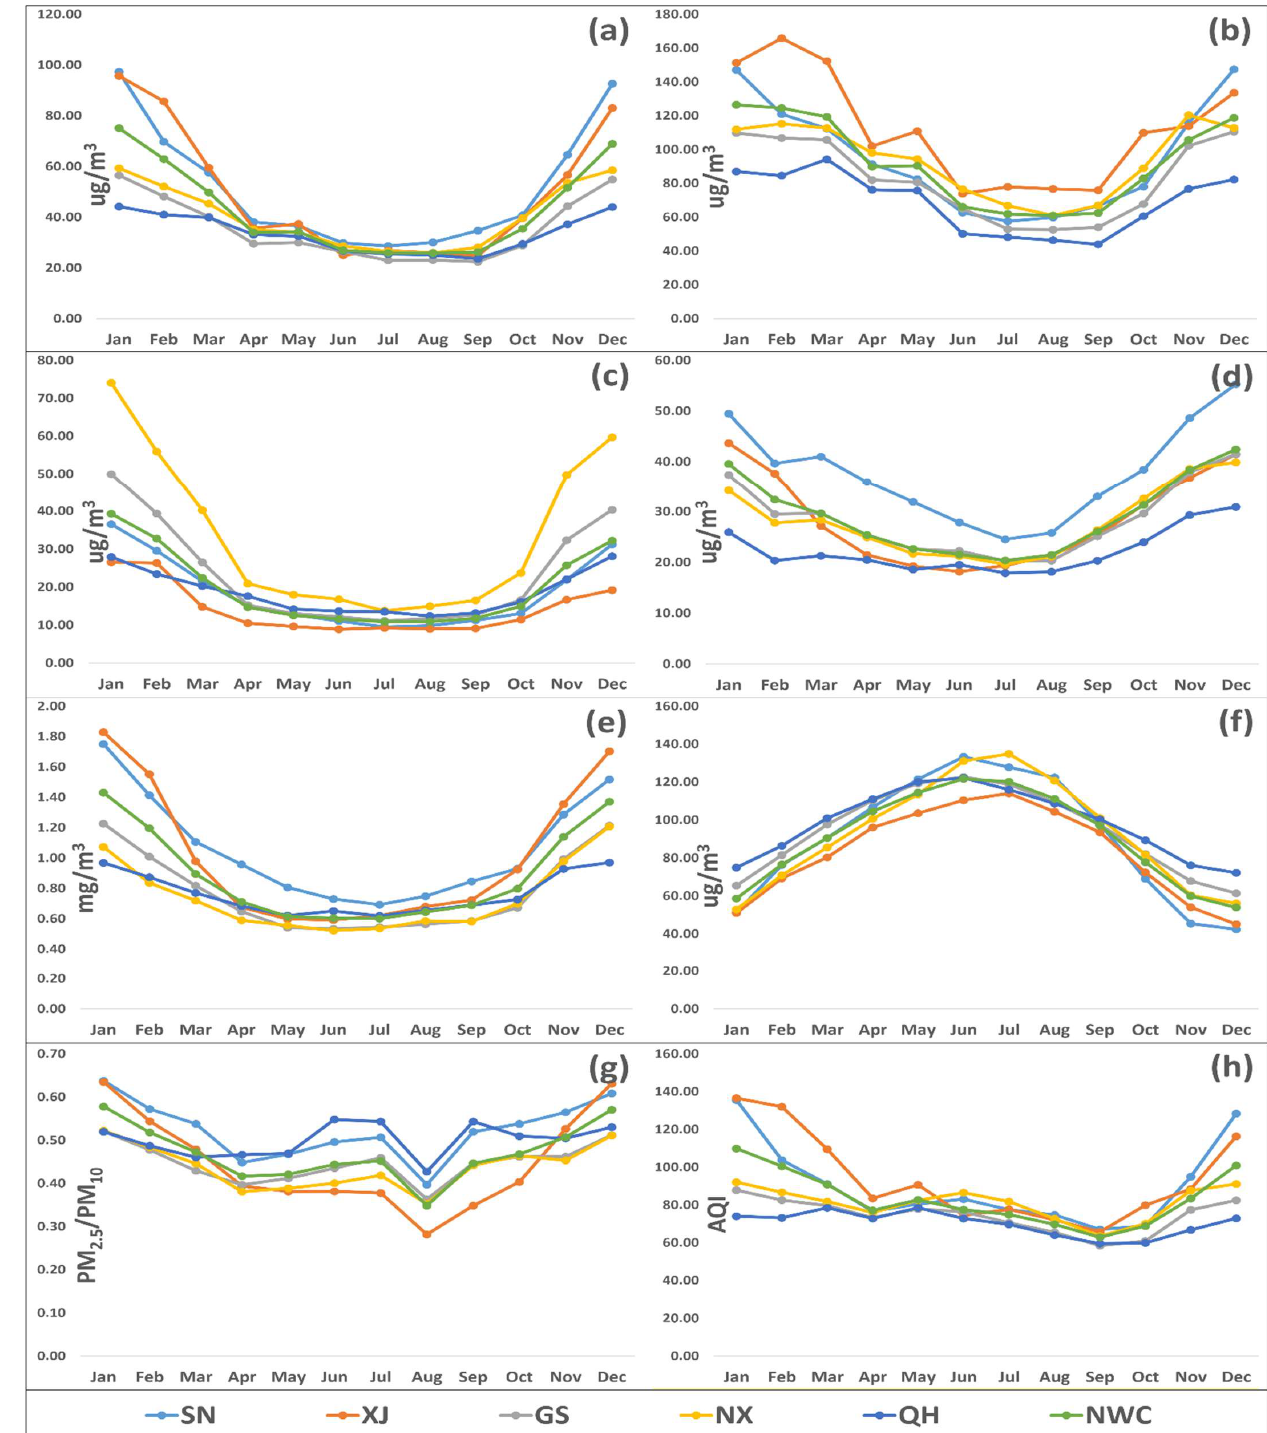
Figure 4. The monthly average concentration of PM 2.5 ( a ), PM 10 ( b ), SO 2 ( c ), NO 2 ( d ), CO ( e ), O 3 ( f ), PM 2.5 /PM 10 ( g ), and AQI ( h ) in five provinces (Shaanxi (SN), Xinjiang (XJ), Gansu (GS), Ningxia (NX), and Qinghai (QH)) of northwest China (NWC) between 2015 and 2018. Descriptions are as follows: light blue line with dots (SN), orange line with dots (XJ), grey line with dots (GS), yellow line with dots (NX), blue line with dots (QH), and parrot line with dots (NWC). The abbreviations are as follows: PM 2.5 (fine particulate matter), PM 10 (coarse particulate matter), SO 2 (sulfur dioxide), NO 2 (nitrogen dioxide), CO (carbon monoxide), and O 3 (ozone).